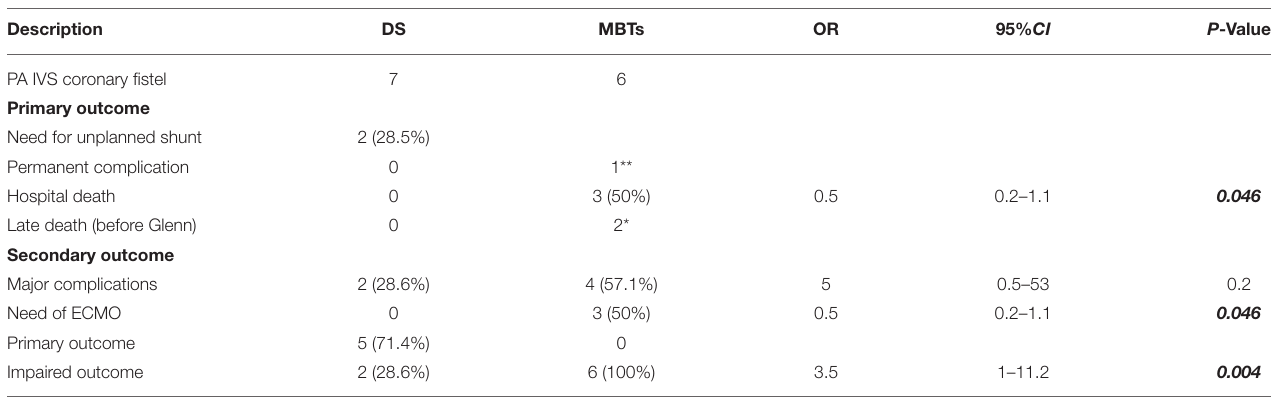
TABLE 3 | DS vs. MBTs in patients with PA-IVS with coronary